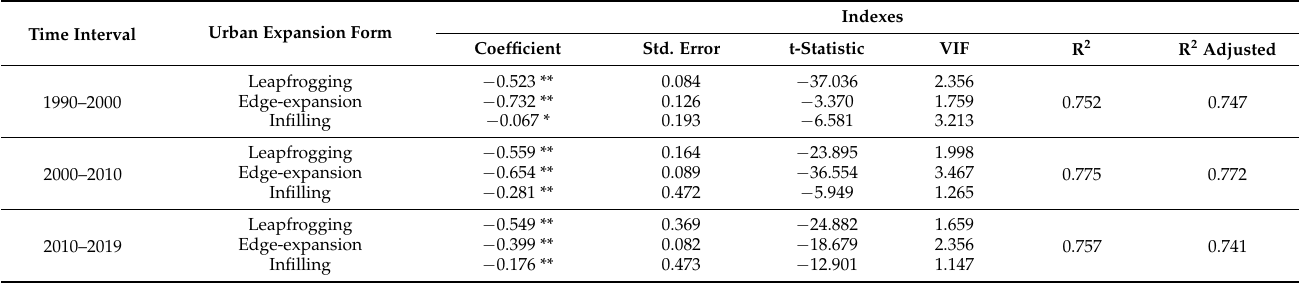
Table 6. The variance analysis results of the MLR model for the expansion intensity of urban expansion forms and the change in CS in different time intervals.